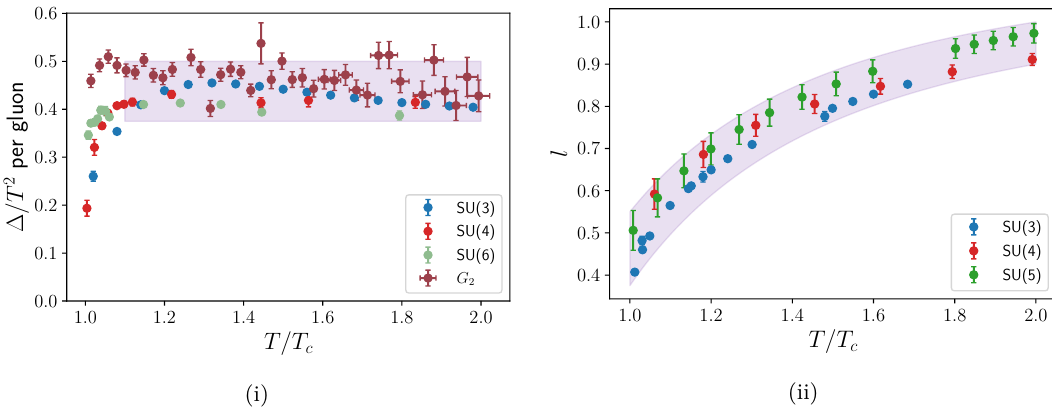
Figure 1. The behavior of thermodynamic quantities on the lattice; the data for the interaction measure (i) is taken from [60] for SU(3), from [61, 62] for SU(4) and SU(6) (the figure only shows data points from [61] for clarity) and for the exceptional group G 2 adapted from [57]. The data for the renormalized Polyakov loop (ii) of SU( N ) is reproduced from ref. [63] for N = 3 , and [64] for N = 4 and N = 5